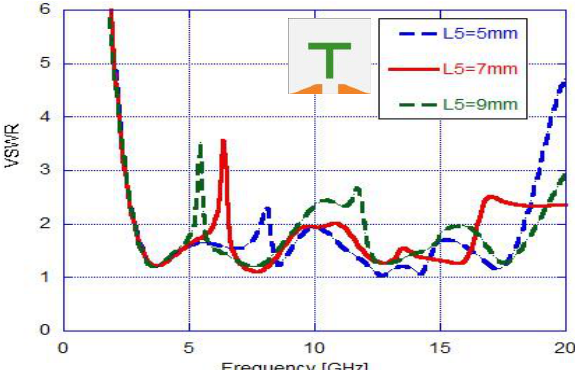
Figure 6: Simulated return loss and VSWR for different values L 5 .